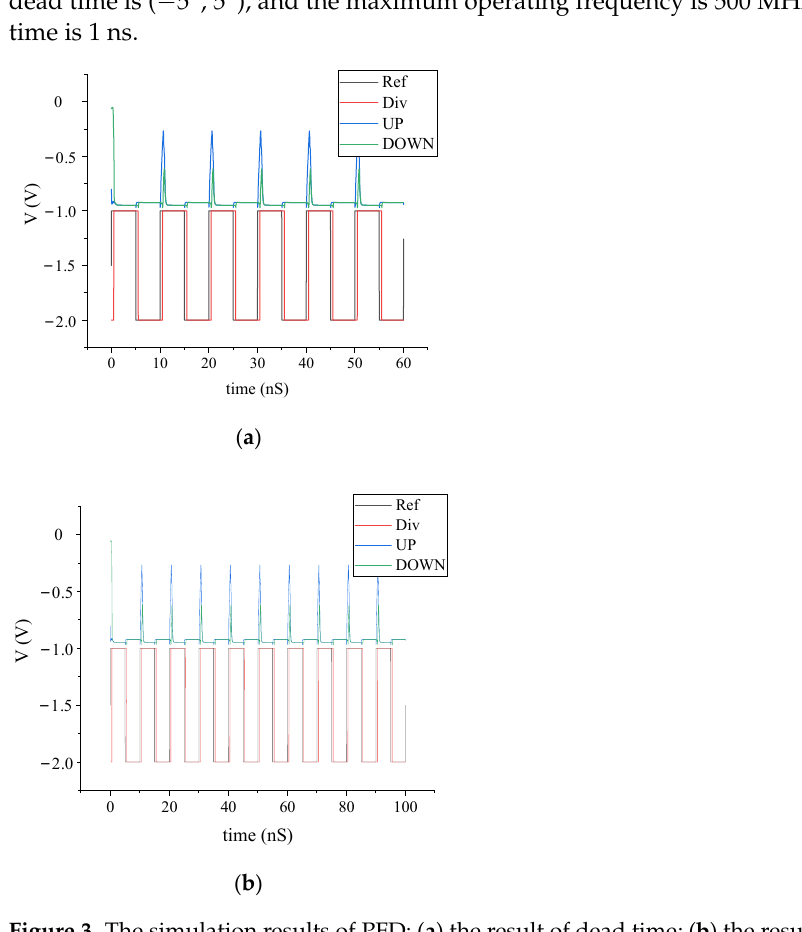
Figure 3. The simulation results of PFD: ( a ) the result of dead time; ( b ) the result of the maximum operating frequency.